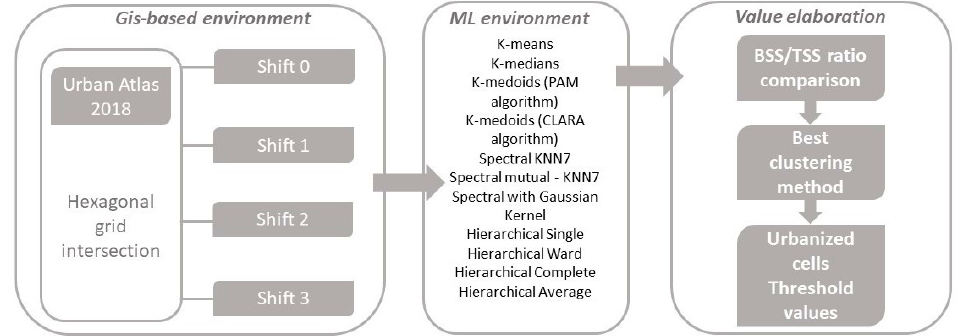
Figure 5. Approach